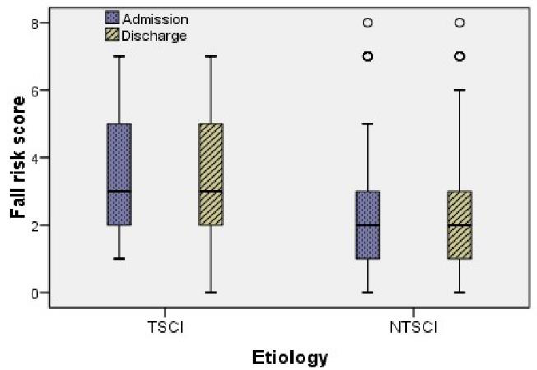
Figure 2. The distribution of fall risk scores across categories of etiology (T-SCI/NT-SCI).